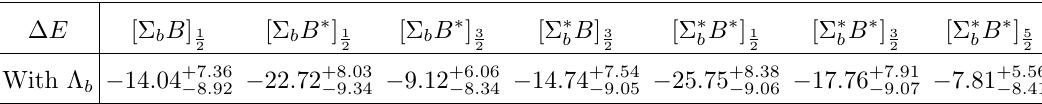
hidden-bottom [(cid:6) ( (cid:3) ) B ( (cid:3) ) ] J systems with b 2